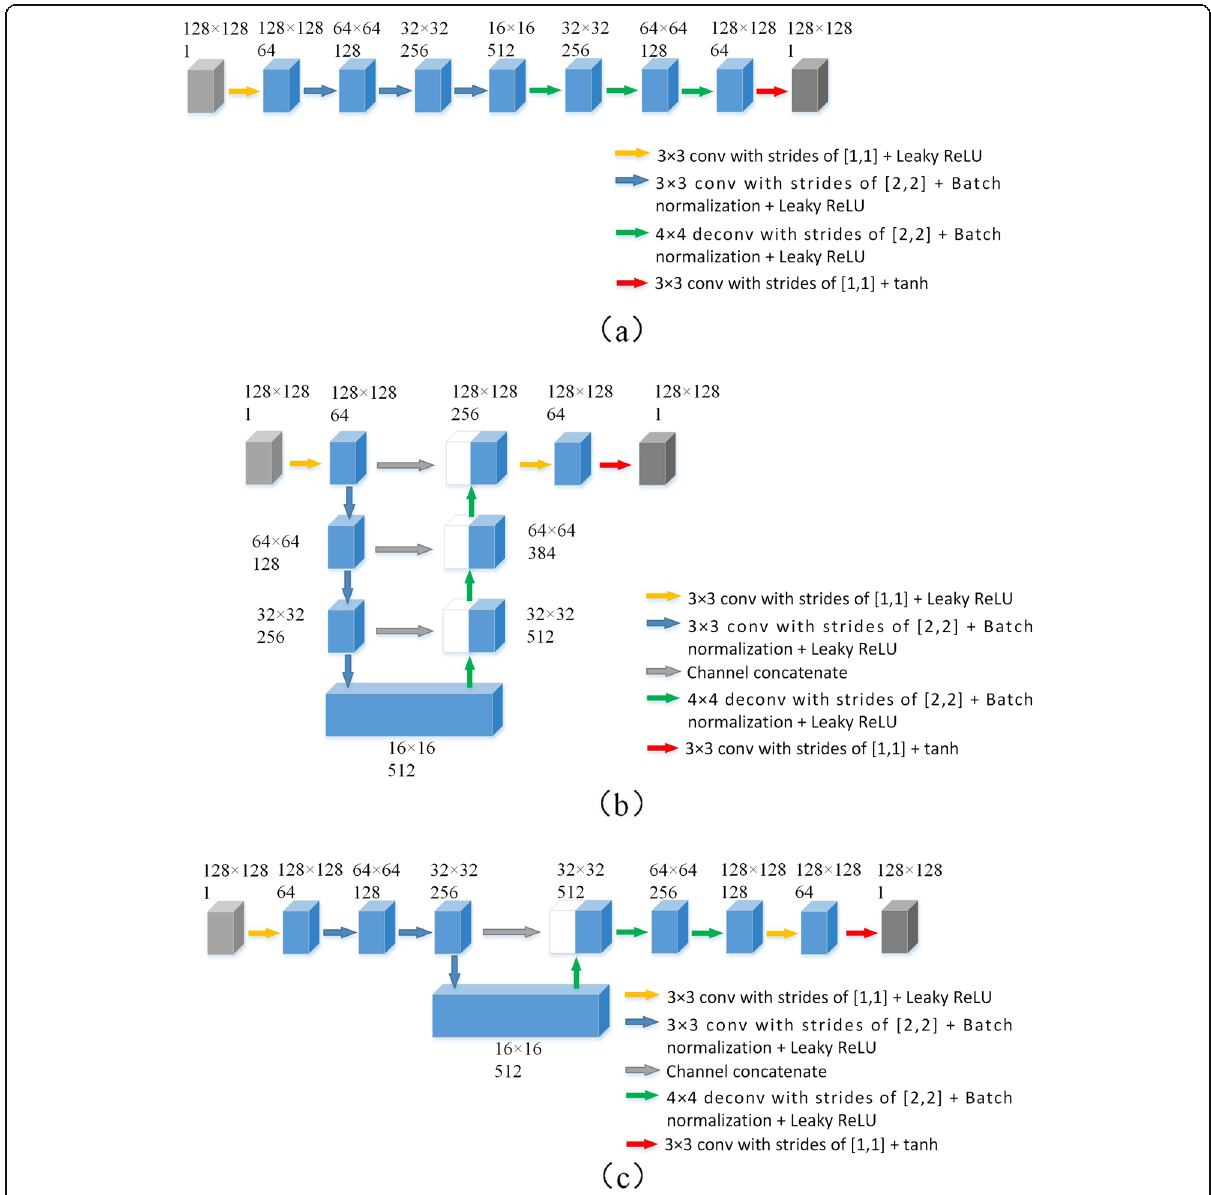
Fig. 2 An encoder-decoder model ( a ) and a U-Net model ( b ); Our SSC U-Net model ( c